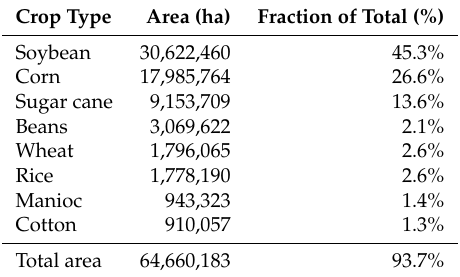
Table 2. Temporary